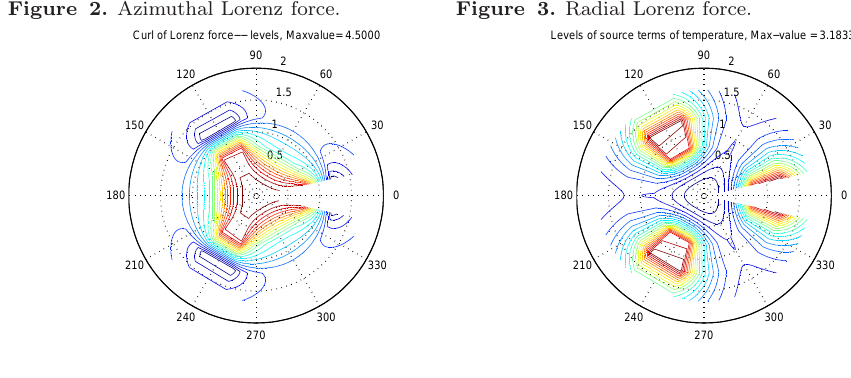
Figure 2. Azimuthal Lorenz force. Figure 3. Radial Lorenz force.